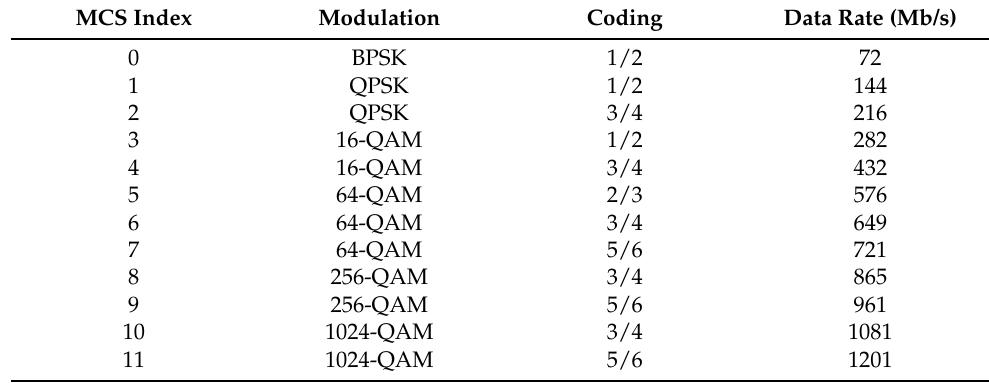
Table 4. MCS maximum data rates in a 160 MHz channel for one spatial stream. Payload symbol duration and guard interval are 12.8 µ s and 0.8 µ s, respectively.